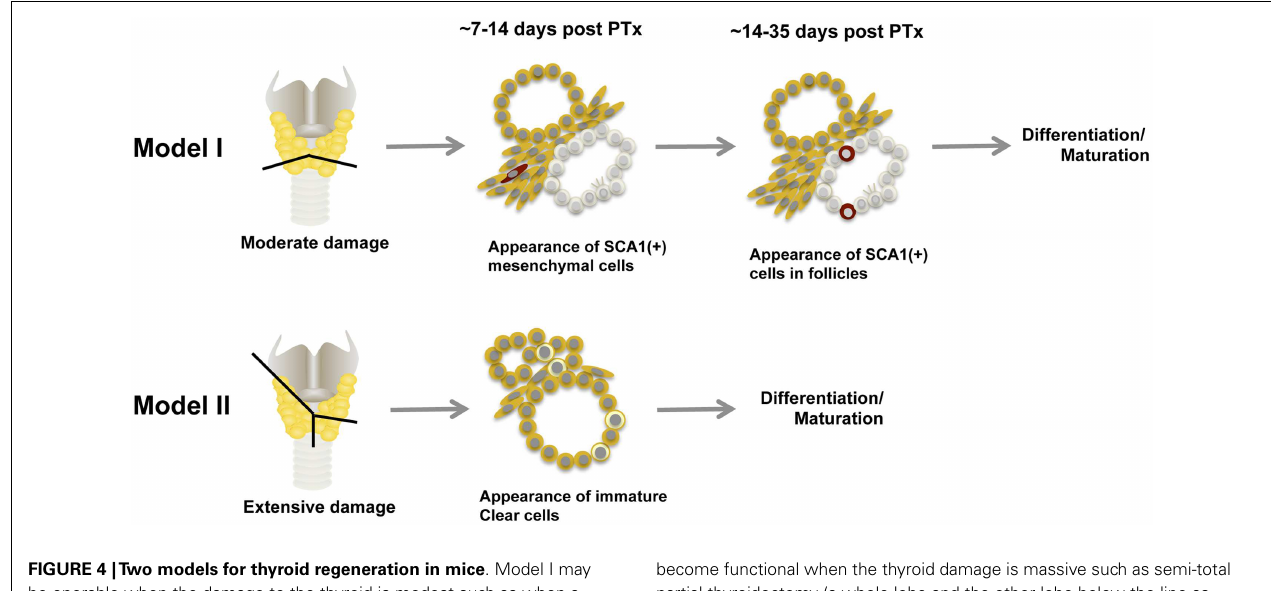
FIGURE 4 |Two models for thyroid regeneration in mice . Model I may be operable when the damage to the thyroid is modest such as when a small portion of thyroid (tissues below the line) is removed.This model may take 2–4weeks to start producing functionally matured thyrocytes, and may involve immature cells in SCN. SCA1-expressing cells and SCN-like immature cells are shown in red and in pale color, respectively. Ciliated cells are also shown within the immature cells. Model II may